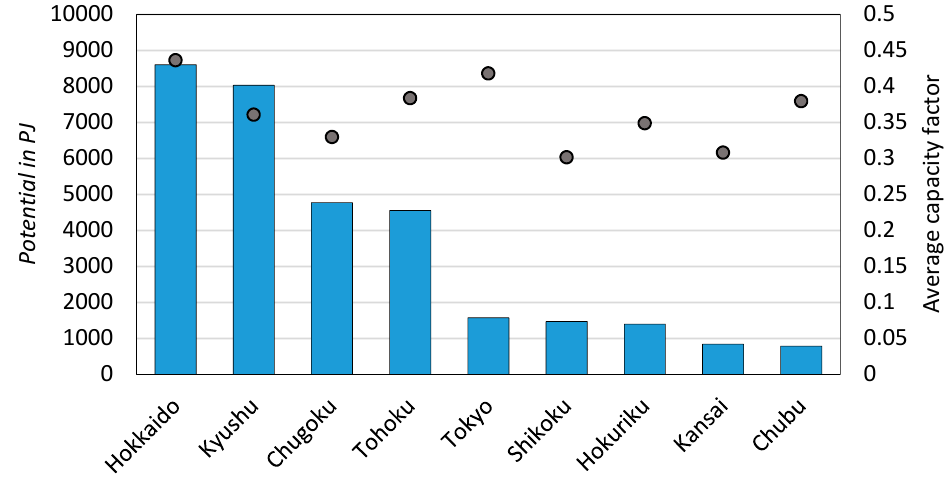
Figure 7. Total electricity potential (blue bars) and average capacity factor (gray dots) per region (2018).